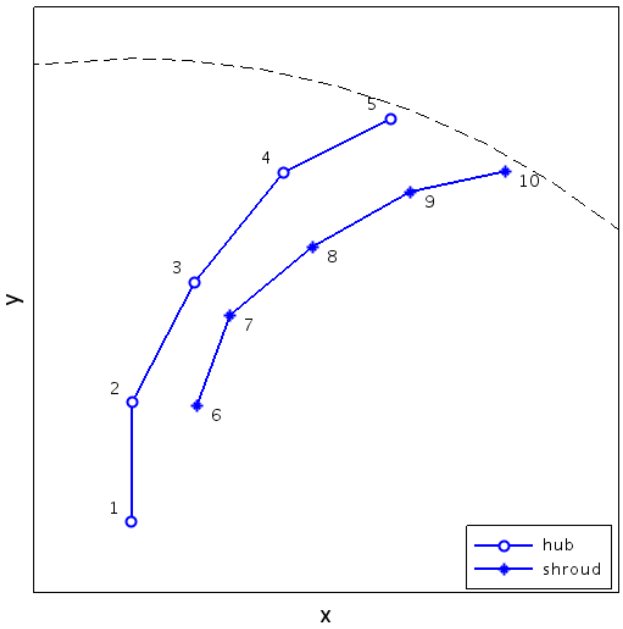
Figure 3. Control points for the camber surface at the hub and shroud.